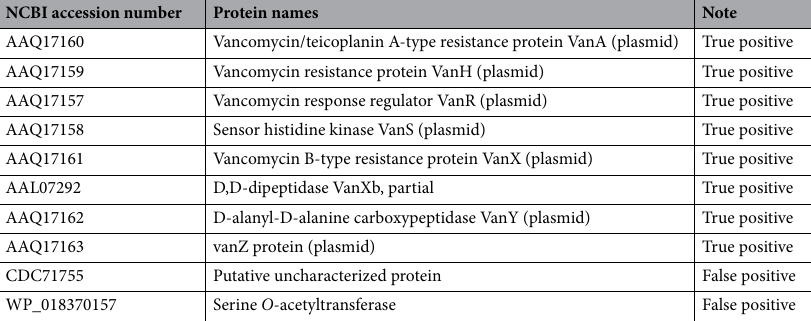
Table 2. Predicted van AMR sequences for Staphylococcus , Streptococcus , and Listeria using the GTDWFE